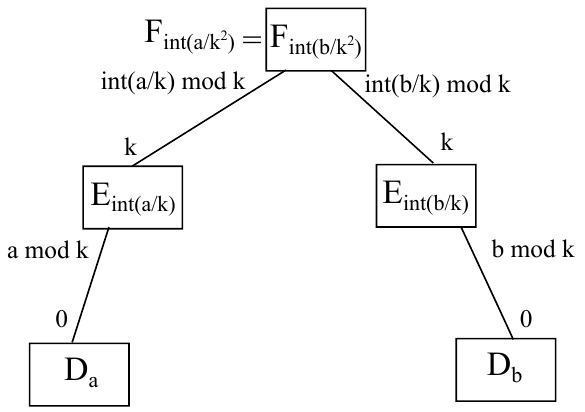
Figure 10. Schematic diagram for intrafog